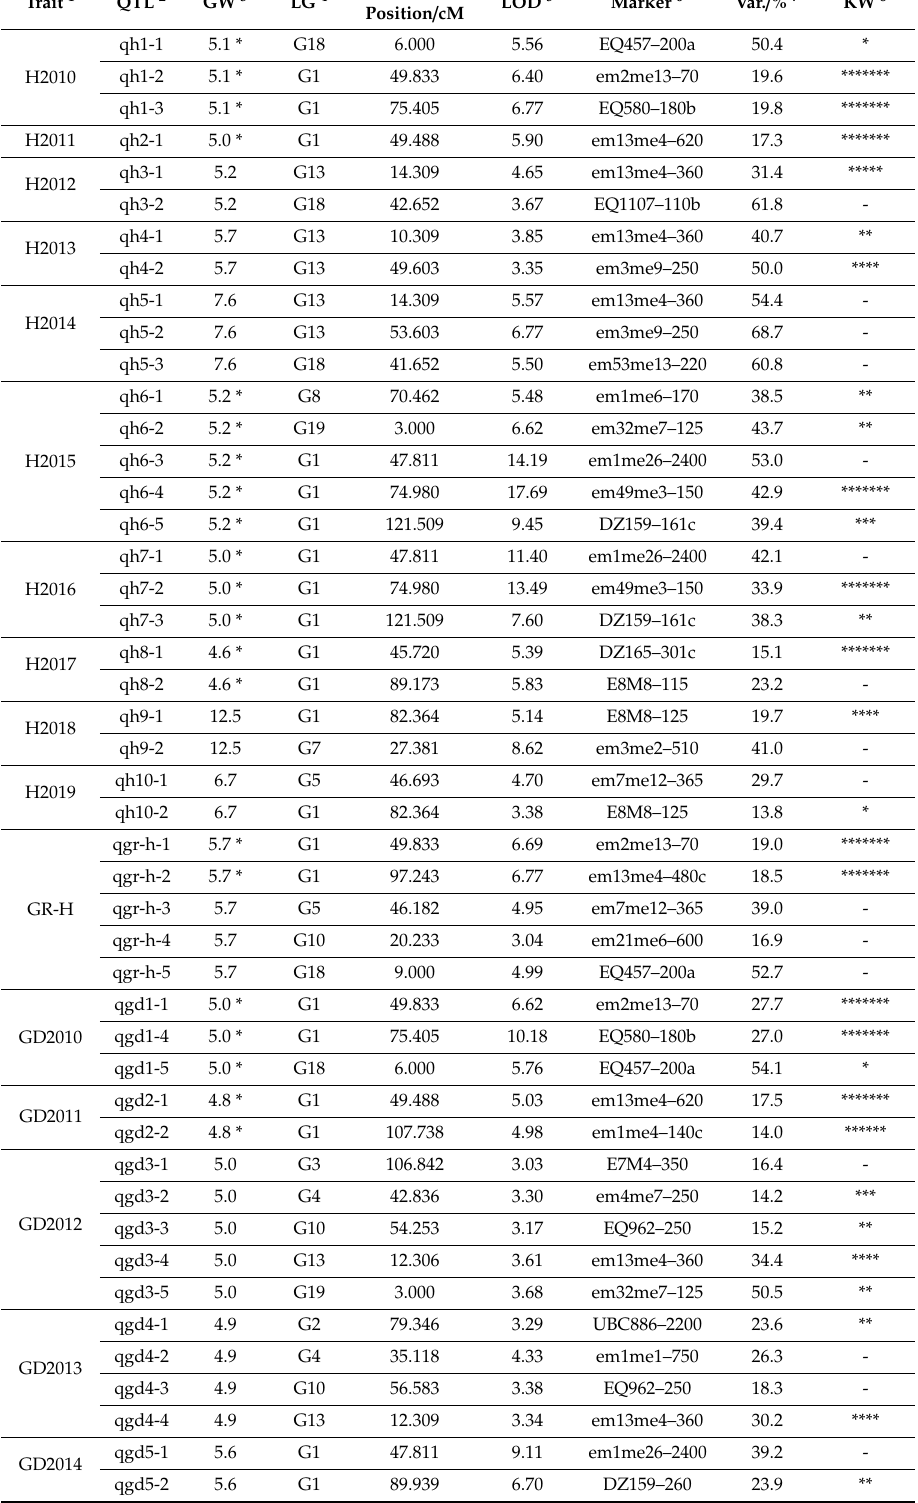
Table 3. Descriptions of quantitative trait loci (QTLs) a ff ecting growth traits in Eucommia ulmoides